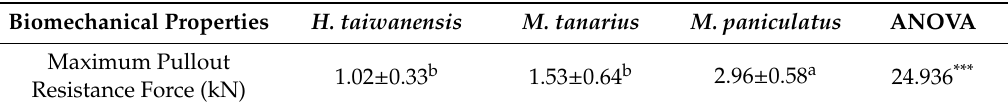
Figure 3. Typical pullout force-displacement curves for the three species studied. Table 5. Means ± standard deviations of maximum pullout resistance force for the three species studied and the F-values for a one-way ANOVA.